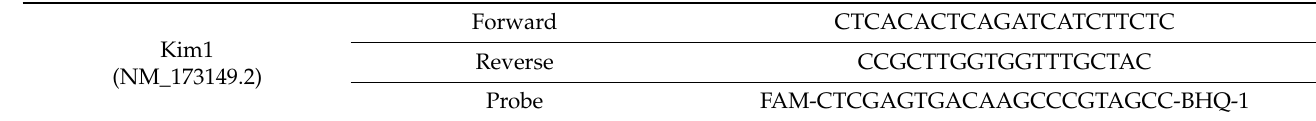
Table 2. Forward and reverse primers as well as the fluorogenic probe sequences that were used in the real-time quantitative PCR analysis. KIM-1: kidney injury molecule-1; NGAL: neutrophil gelatinase-associated lipocalin, also called lipocalin 2 (Lcn2); TNF- α : tumour necrosis factor-alpha; TGF- β 1: transforming growth factor- β ; p53: the pro-apoptotic gene; and COL1A: procollagen